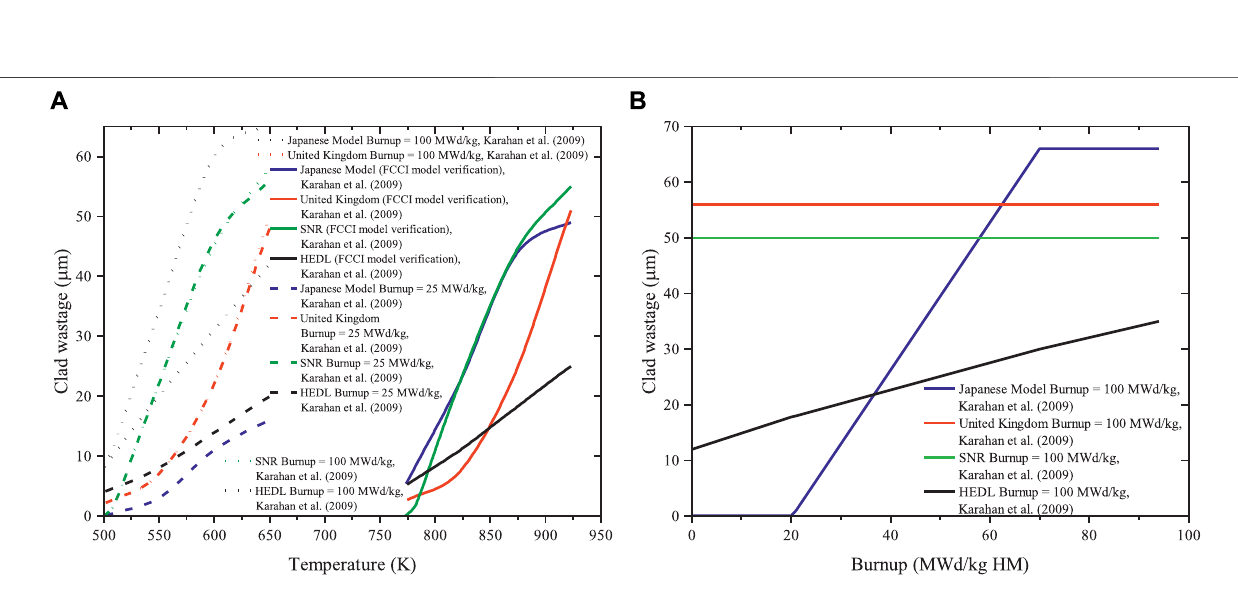
Frontiers in Energy Research |